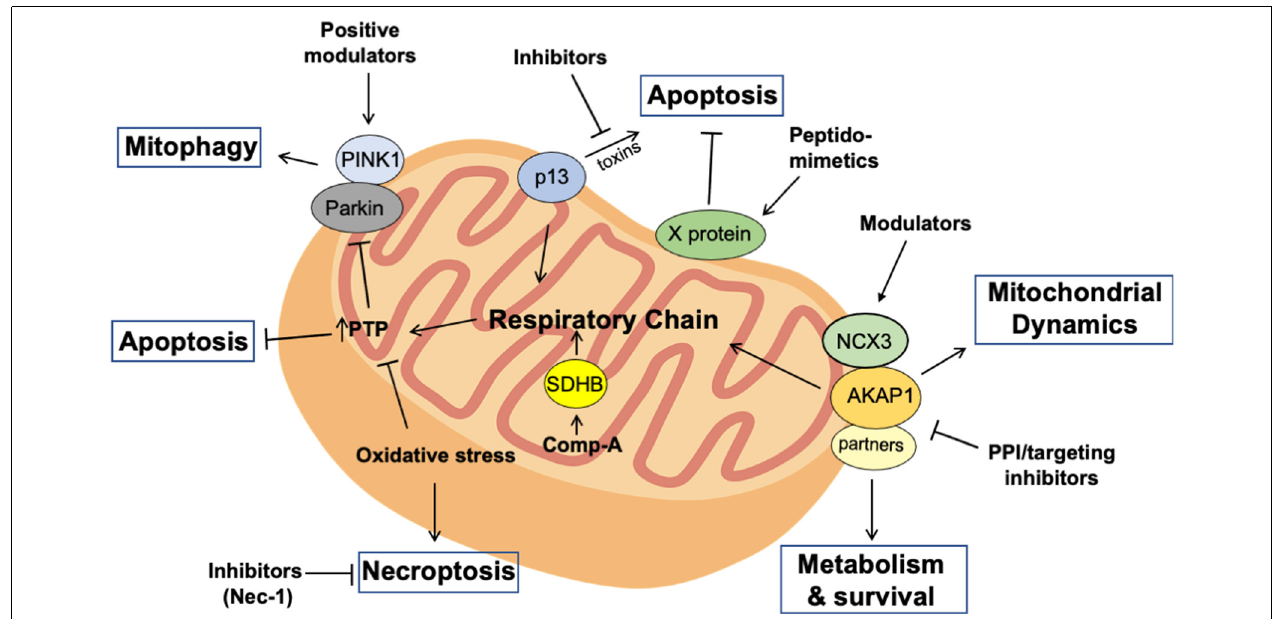
FIGURE 1 | Targeting mitochondria for the treatment of Parkinson’s disease (PD). Distinct experimental approaches can be used to selectively interfere with the mutation-induced deregulation of mitochondrial activities in PD neurons. Thus, deranged mitochondrial cAMP signaling can be restored using protein-protein interaction (PPI)/targeting molecules that support the assembly of A-Kinase Anchor Protein (AKAP) complexes at mitochondria. This would positively impact on cell survival and metabolism of PD neurons. Similarly, peptidomimetics that positively regulate X protein activity at mitochondria have been successfully used to prevent oxidative stress and apoptotic cell death induced by mitochondrial toxins. Similarly, inhibiting p13 or treating with necrosis inhibitors (Nec-1) in toxin-induced or familial forms of PD positively impacts on oxidative metabolism and neuronal survival. Moreover, restoring PINK1-Parkin pathway using selective agonists or preventing ubiquitin-specific protease (USP)-mediated deubiquitination of Parkin substrates with selective USP inhibitors could restore mitophagy in PD neurons, preventing accumulation of damaged mitochondria, oxidative stress, and neuronal apoptosis. Finally, sustaining the activity of respiratory enzymes as succinate dehydrogenase subunit B (SDHB) with chemical drugs represents a promising therapeutic approach to restore oxidative metabolism and mitochondrial permeability transition pore (PTP), preventing apoptotic or necroptotic neuronal